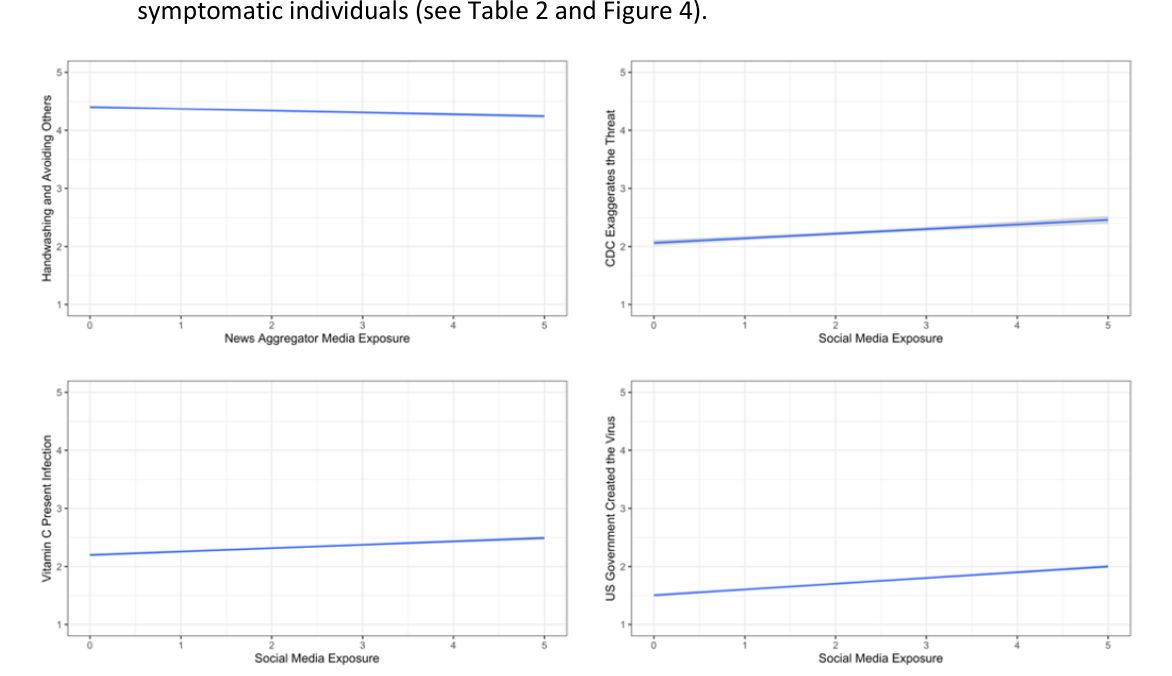
Figure 4. Associations between Yahoo or Google News Aggregators or Social Media Exposure and Information/Misinformation3.